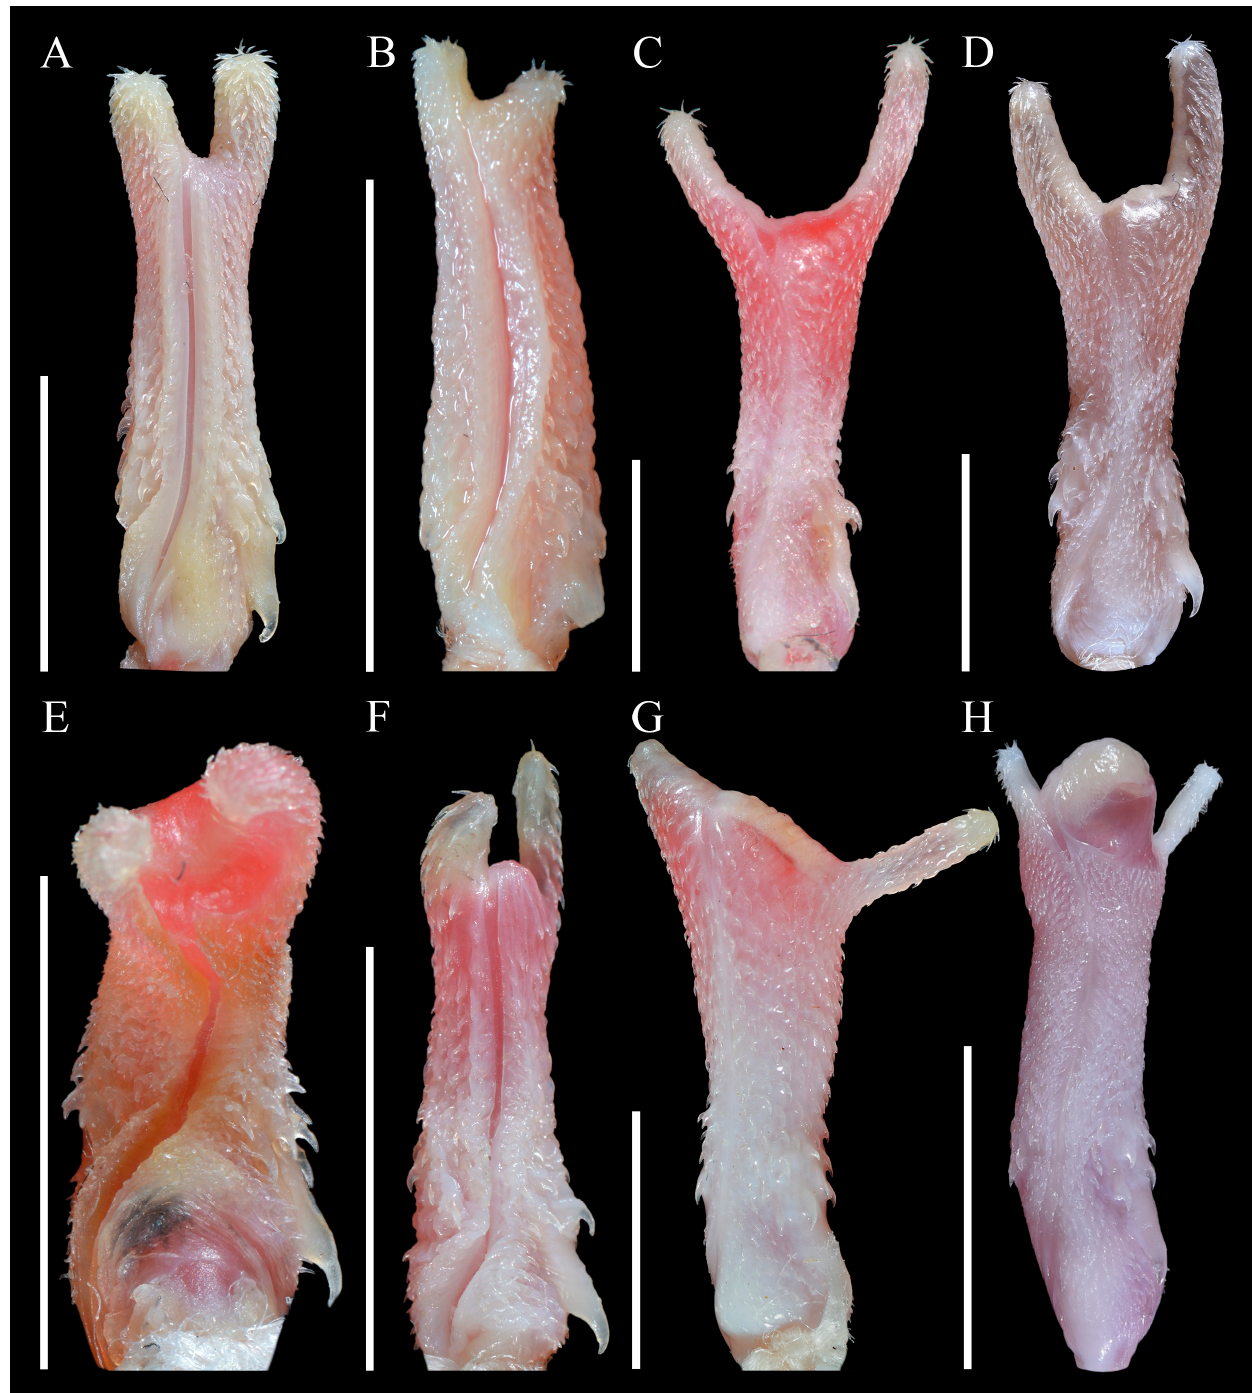
Figure A1. ( A ). Hebius bitaeniatus , SYS r002171; ( B ). Hebius septemlineatus , SYS r001225, basal hook broken; ( C ). Hebius weixiensis , SICAU 2020082701; ( D ). Hebius metusia , CIB 118638; ( E ). Hebius sauteri , SYS r002041; ( F ). Hebius popei , SYS r002252; ( G ). Hebius boulengeri , CIB 118637; ( H ). Hebius optatus , unlabeled. Information see Appendix A. Scale bar = 5 mm. Photographs by Jun ‐ Jie Huang and Jin ‐ Long Ren.